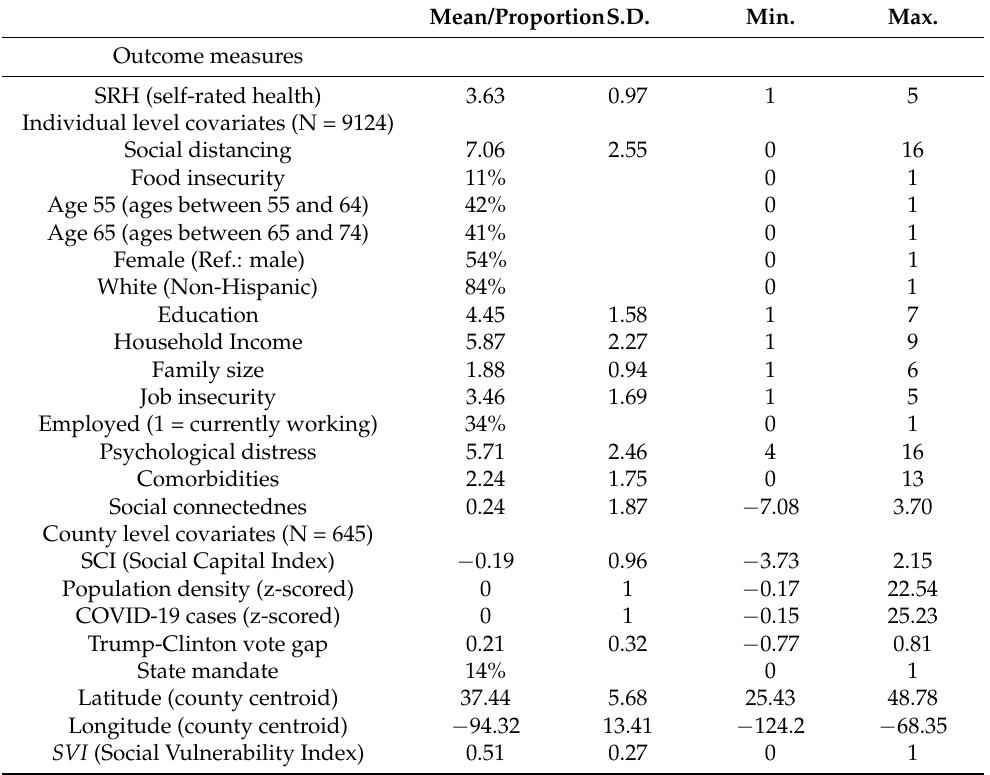
Table 1. Descriptive Statistics, Definitions, and Coding Procedures.